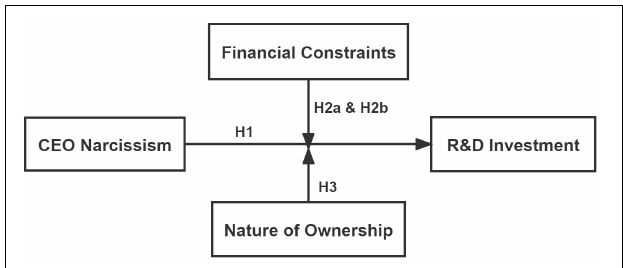
FIGURE 1 | Research